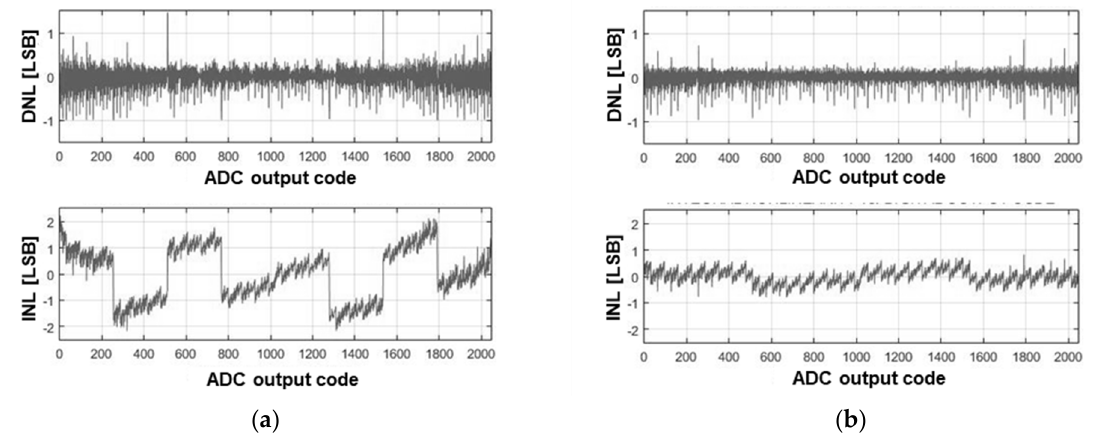
Figure 9. Measured static performances of 11-bit SAR ADC: ( a ) before C–R DAC calibration; ( b ) after C–R DAC calibration.